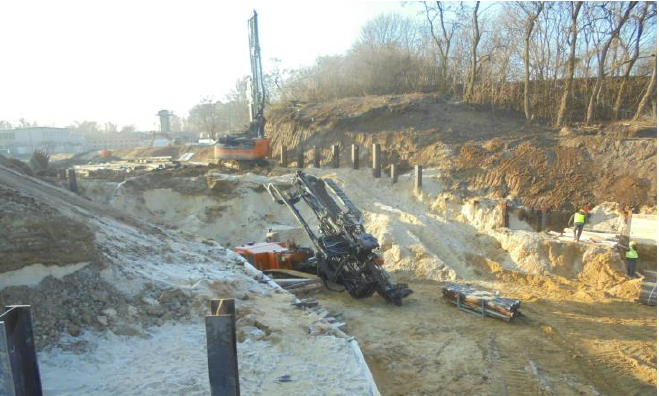
Figure 5. Passage of the communication corridor through the anthropogenic embankments: construction of the soldier pile wall. Clearly visible uncovered substrate layers of different colors.